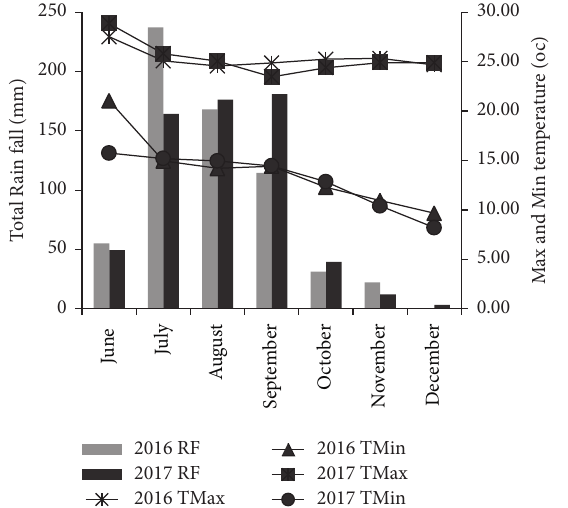
Figure 2: Total rainfall and minimum and maximum temperature from June to December (2016–2017) at Minjar. Table 1: Soil physiochemical properties of the experimental sites. Debre Zeit